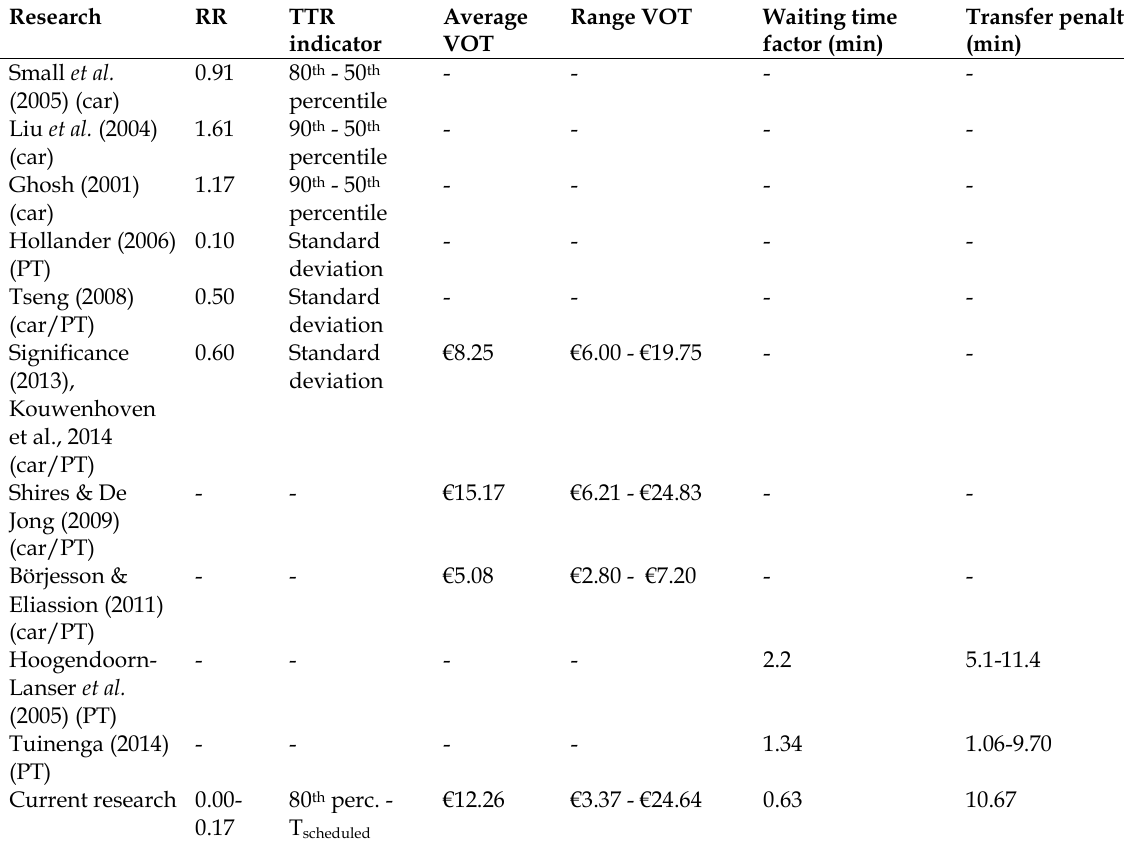
Table 7. Comparison with results of other